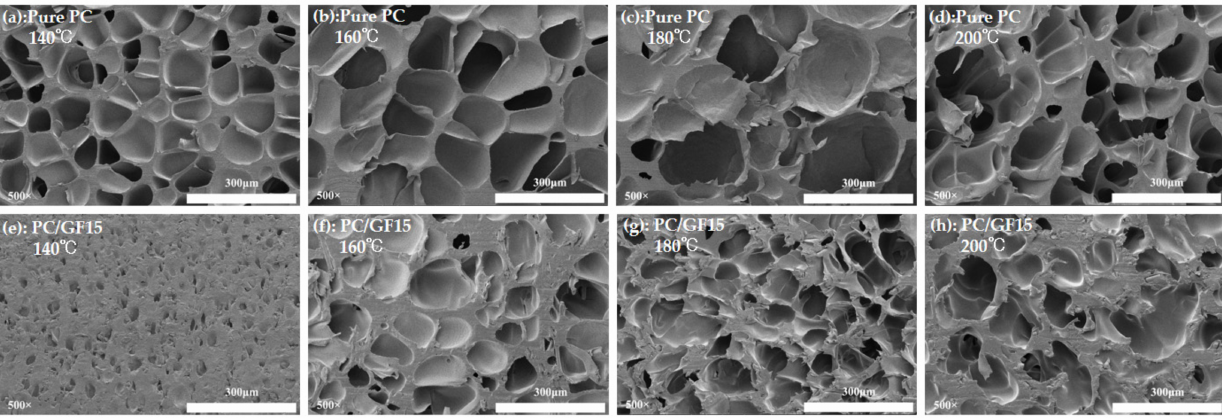
Figure 10. SEM micrographs of foamed PC and PC/15 % GF at different foaming temperatures. PC ( a ) 140 ◦ C, ( b ) 160 ◦ C, ( c ) 180 ◦ C, ( d ) 200 ◦ C. PC/15%GF ( e ) 140 ◦ C, ( f ) 160 ◦ C, ( g ) 180 ◦ C, ( h ) 200 ◦